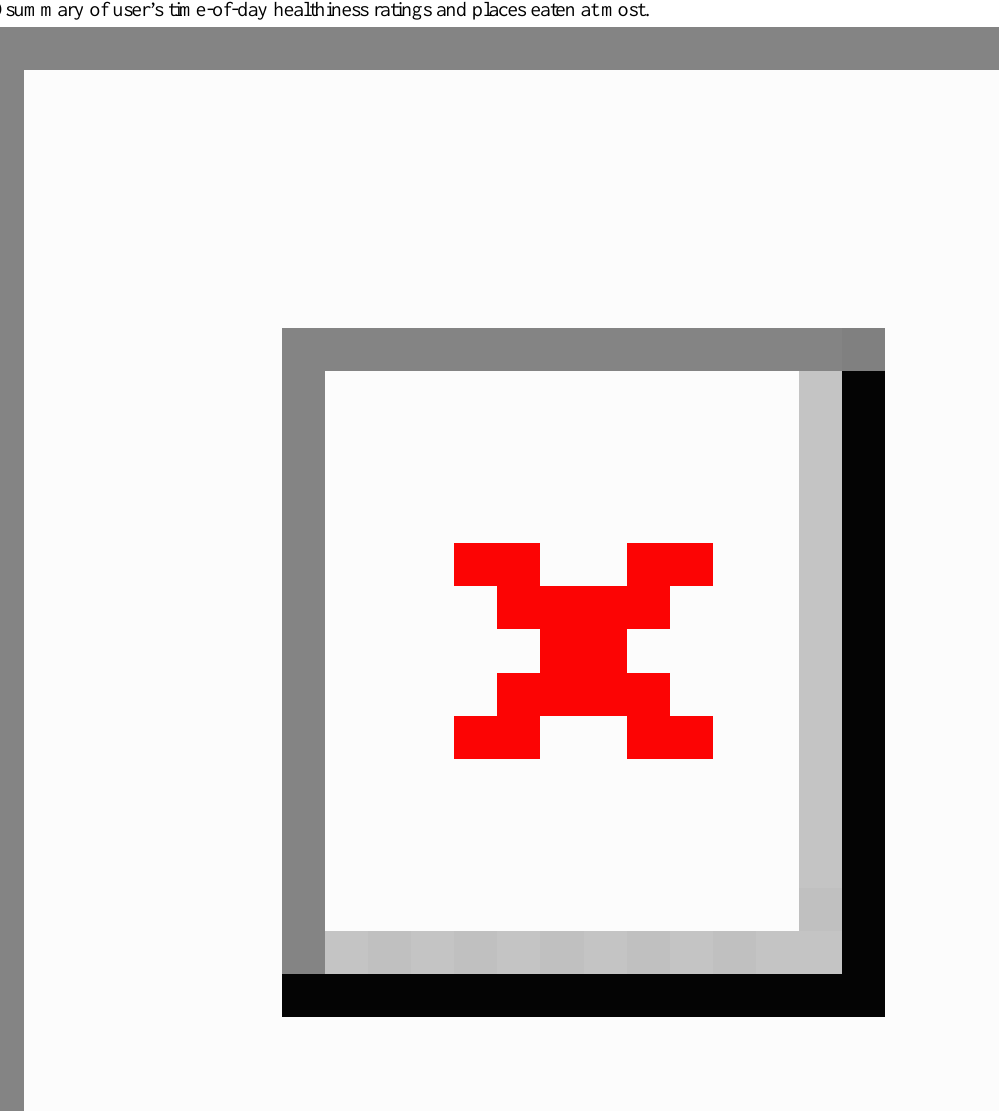
Figure 1. Screenshots of The Eatery app: a) rating other people’s food with fat-fit scale, b) feedback received for photographed food, c) weekly summary, and d) summary of user’s time-of-day healthiness ratings and places eaten at